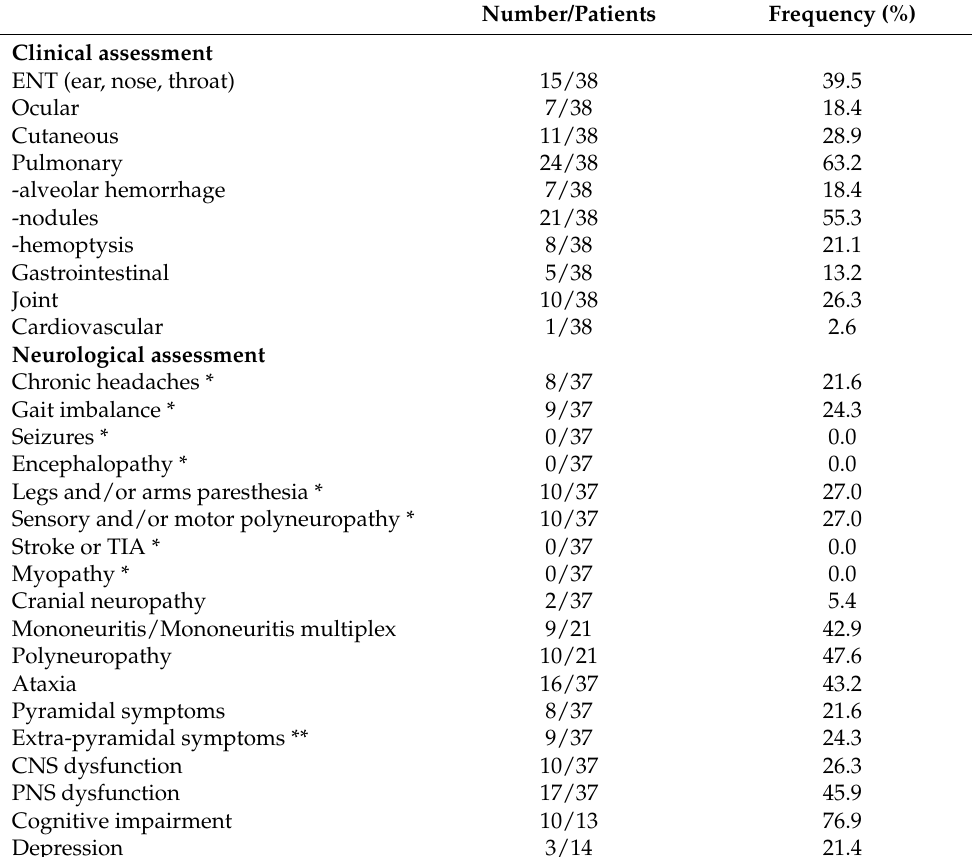
Table 3. Results of the clinical and neurological